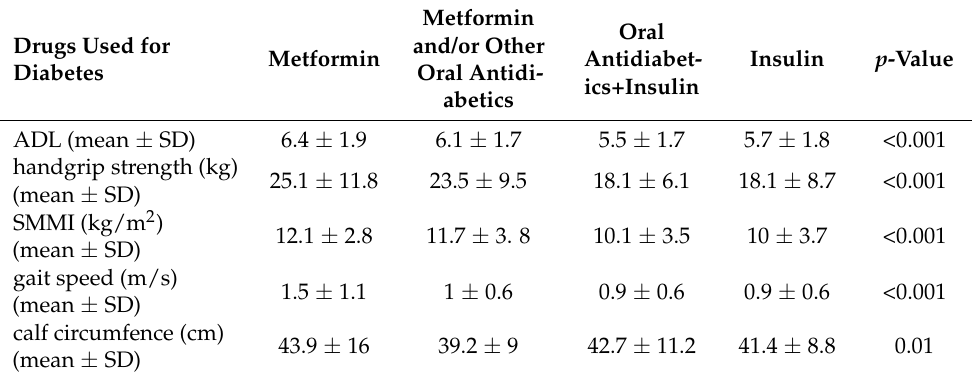
Table 7. Relationship between antidiabetic drugs and geriatric syndromes.